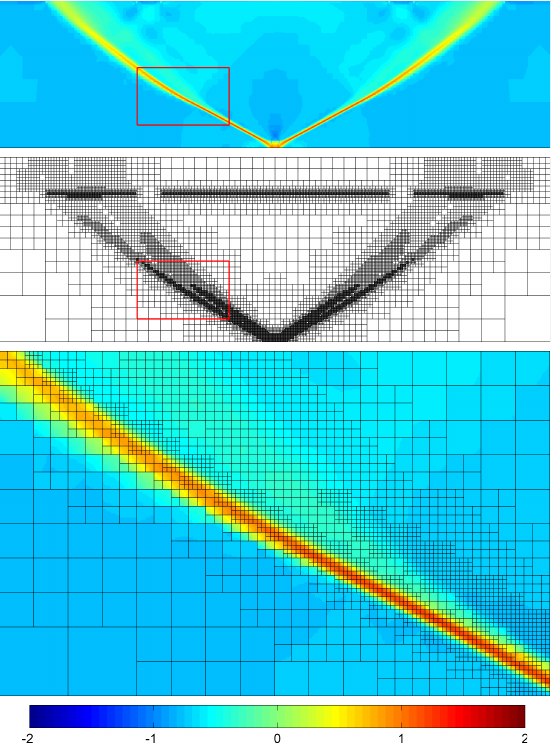
Figure 21. Compression model with φ = 0 ◦ after 0.13% strain; top : log ( ˙ ε II ) plot; middle : numerical grid; bottom : zoom as marked by red